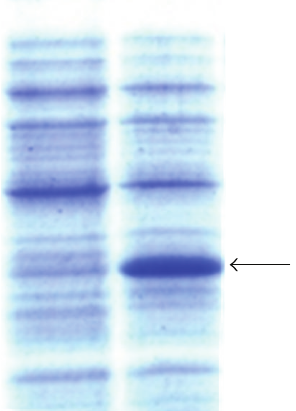
Figure 2: 15% SDS-PAGE of the total biomass before induction (left) and after induction (right). The arrow indicates the target protein ApE1 with predicted mass of 30 kDa.